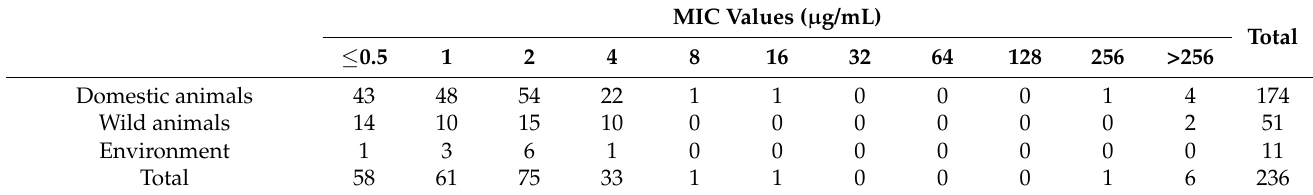
Table 2. Distribution of the tested Salmonella strains in relation to minimum inhibitory concentration (MIC) values and origin of samples.